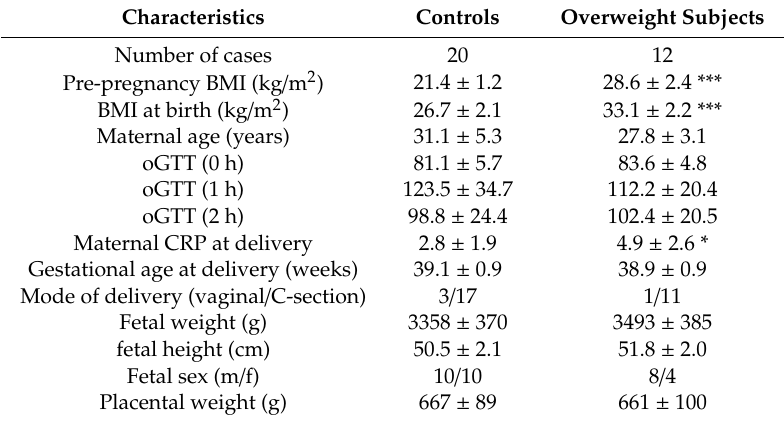
Table 2. Characteristics of the cord blood